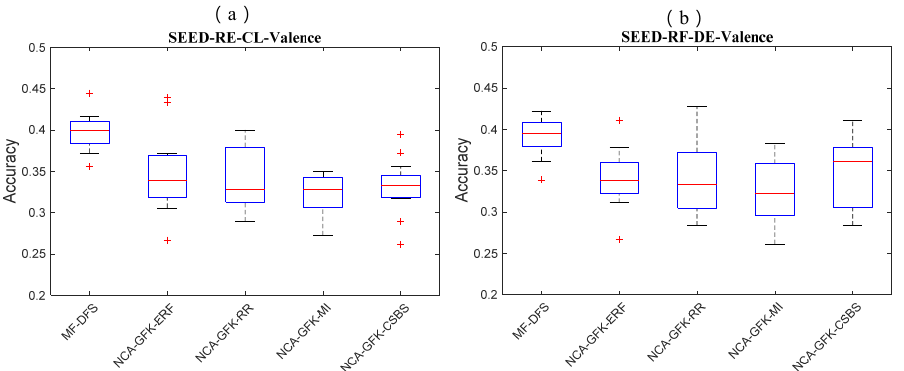
Figure 6. Boxplots of the classification accuracy based on the RF classifier combined with five feature selection methods of the SEED database. The accuracies of CL features for the valence dimension are shown in ( a ). The accuracies of DE feature for the valence dimension are shown in ( b ).